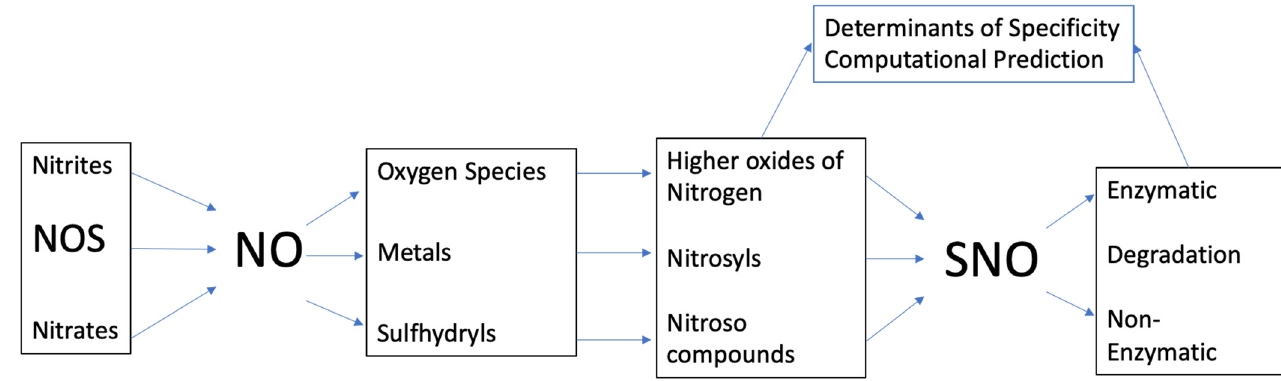
Figure 1. Scheme of areas to be covered in this review. This review will cover the literature of how SNOs are formed with consideration of the sources of NO and the reactants available within the biological milieu and the mechanisms of degradation. There is a focus on how these factors lead to the specificity of SNO formation and how predictive modeling may allow for the determination of sites of SNO formation.